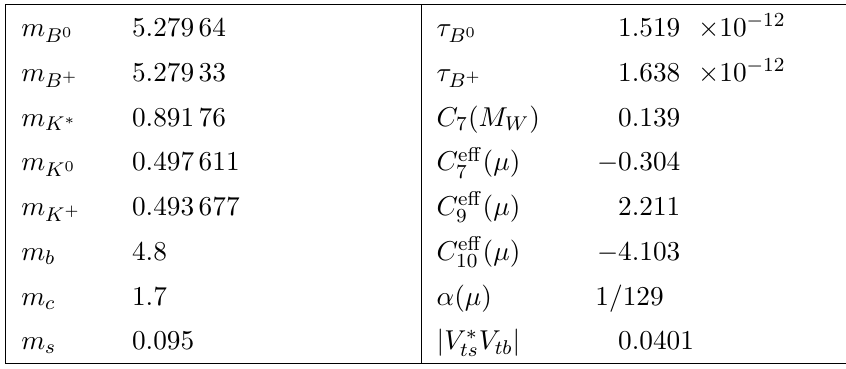
Table 1 . Numerical inputs for the relevant parameters used in the analysis. Central values of meson and quark masses m i and mean lifetimes (cid:28) i are expressed in GeV and seconds units respec- tively [64]. The quark masses m b and m c correspond to the pole masses of bottom and charm quarks respectively. E(cid:11)ective Wilson coe(cid:14)cients at the NNLO C e(cid:11) ( (cid:22) ) (from [10]) and EM (cid:12)ne structure 7 ; 9 ; 10 constant (cid:11) ( (cid:22) ) are intended to be evaluated at the scale (cid:22) = m b . The SM C 7 ( M W ) corresponds to m t = 170 GeV